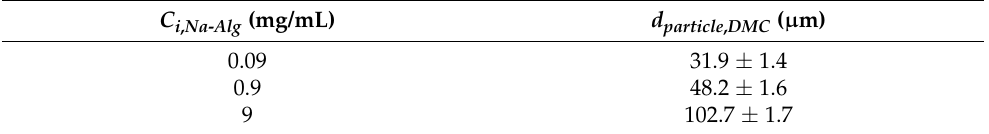
Table 1. Diameter of Na-Alg/Fe 3 O 4 microparticles in DMC ( d particle , DMC ) in function of the initial concentration of Na-Alginate in dispersed fluid ( C i , Na - Alg